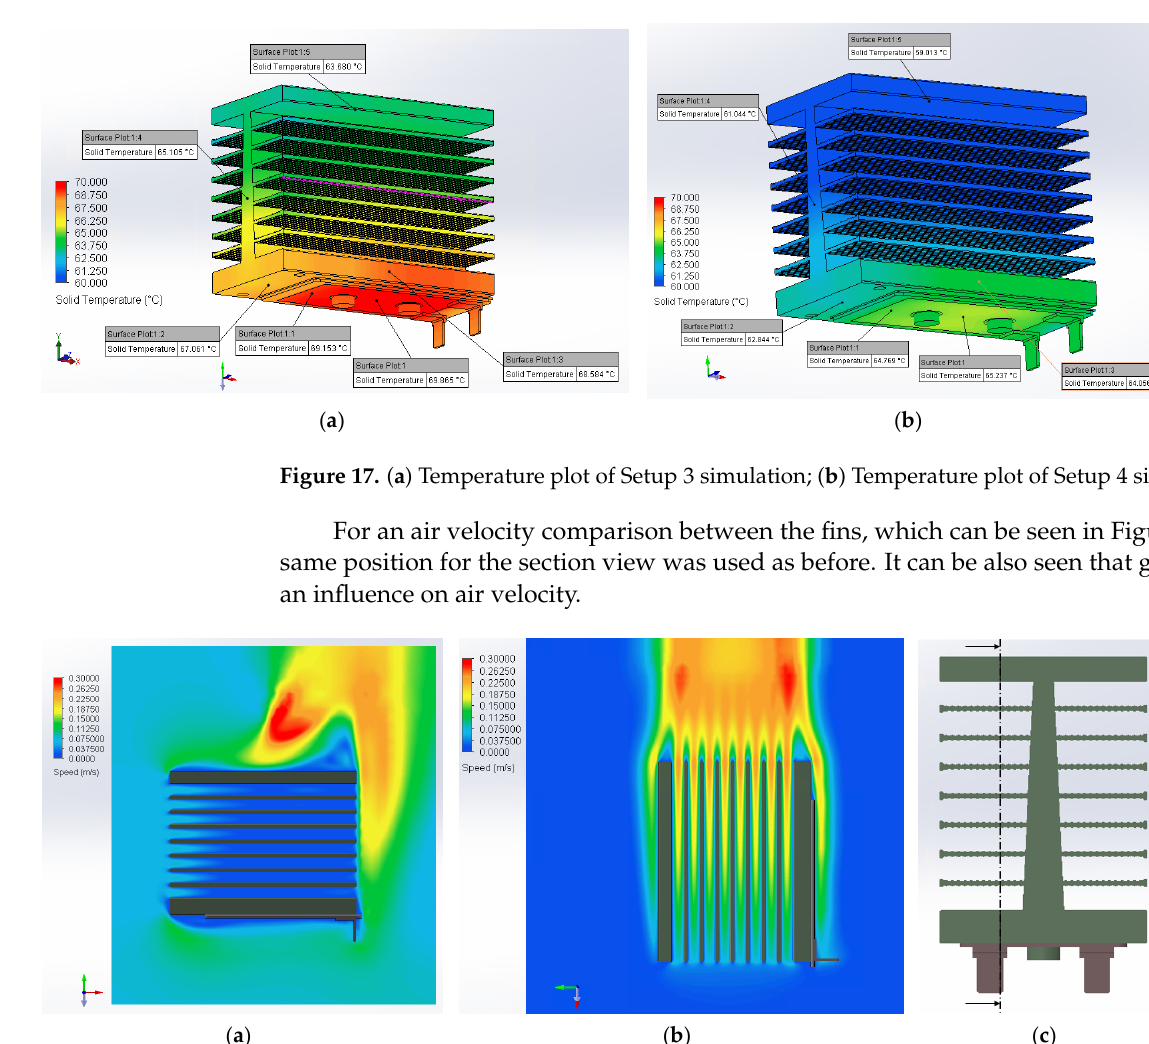
Figure 18. ( a ) Air velocity of Setup 3—section view; ( b ) Air velocity of Setup 4—section view; ( c ) Section plane.